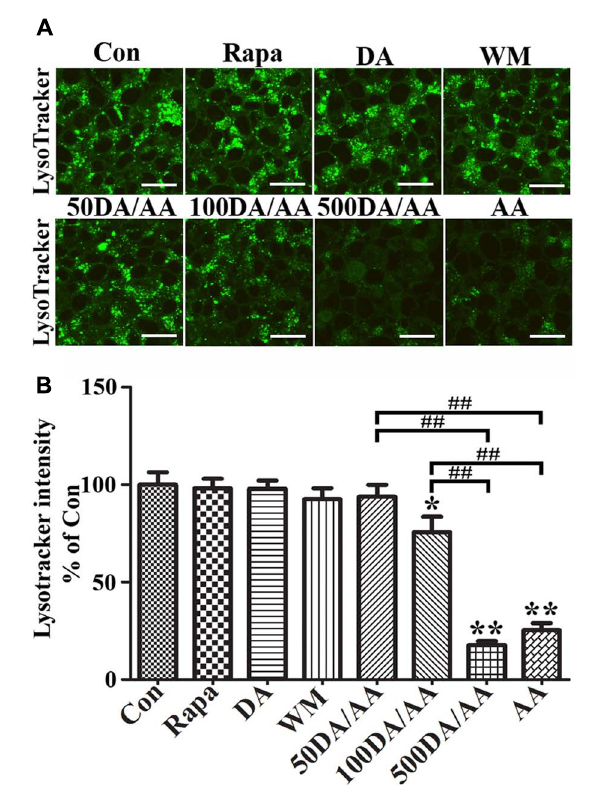
FIGURE 7 |AA treatment induces lysosome dysfunction in 3D5/DAT cells. Eight sets of 3D5/DAT cells cultured on Lab-Tek Chambered Coverglass were subjected to 8 days of differentiation and α -syn induction. They were treated for 60 h with Rapa, DA (50, 100, or 500 μ M),WM, AA, or without any treatment to serve as control (Con). At the end of treatment, LysoTracker Green (invitrogen) was added at a final concentration of 100 nM to each well for 1 h. Cells were then evaluated for lysosomal function by confocal microscopy. (A) Representative images of LysoTracker labeled cells in different groups were shown. (B) Bar graph summarized data from quantitative and statistical analyses of more than 20 images captured from each group. (* p < 0.05, ** p < 0.01 comparing to Con; ## p < 0.01, comparing subsets linked by